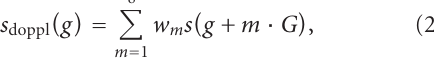
resulted from the fact that monopulse methods are not